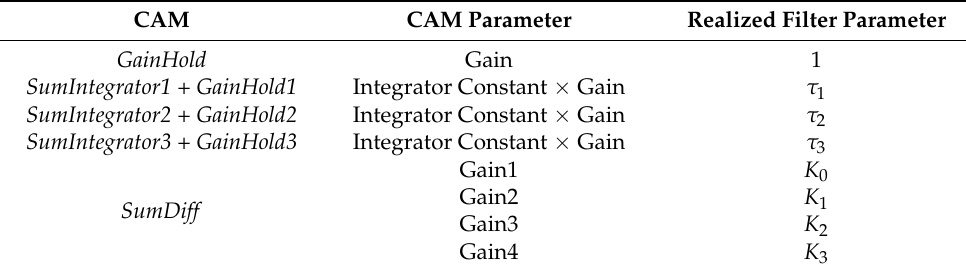
Figure 6. Experimental gain and phase frequency responses (triangle symbols), along with the corresponding approximate (solid lines) and ideal (dashed lines) responses for LP and HP filters of order β = { 1.3,1.5,1.7 } . Table 3. Realized filter parameters of the CAMs of the design in Figure 4.